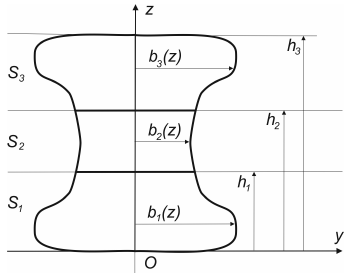
Figure 1. A cross-section of the rod when the number of layers n = 3